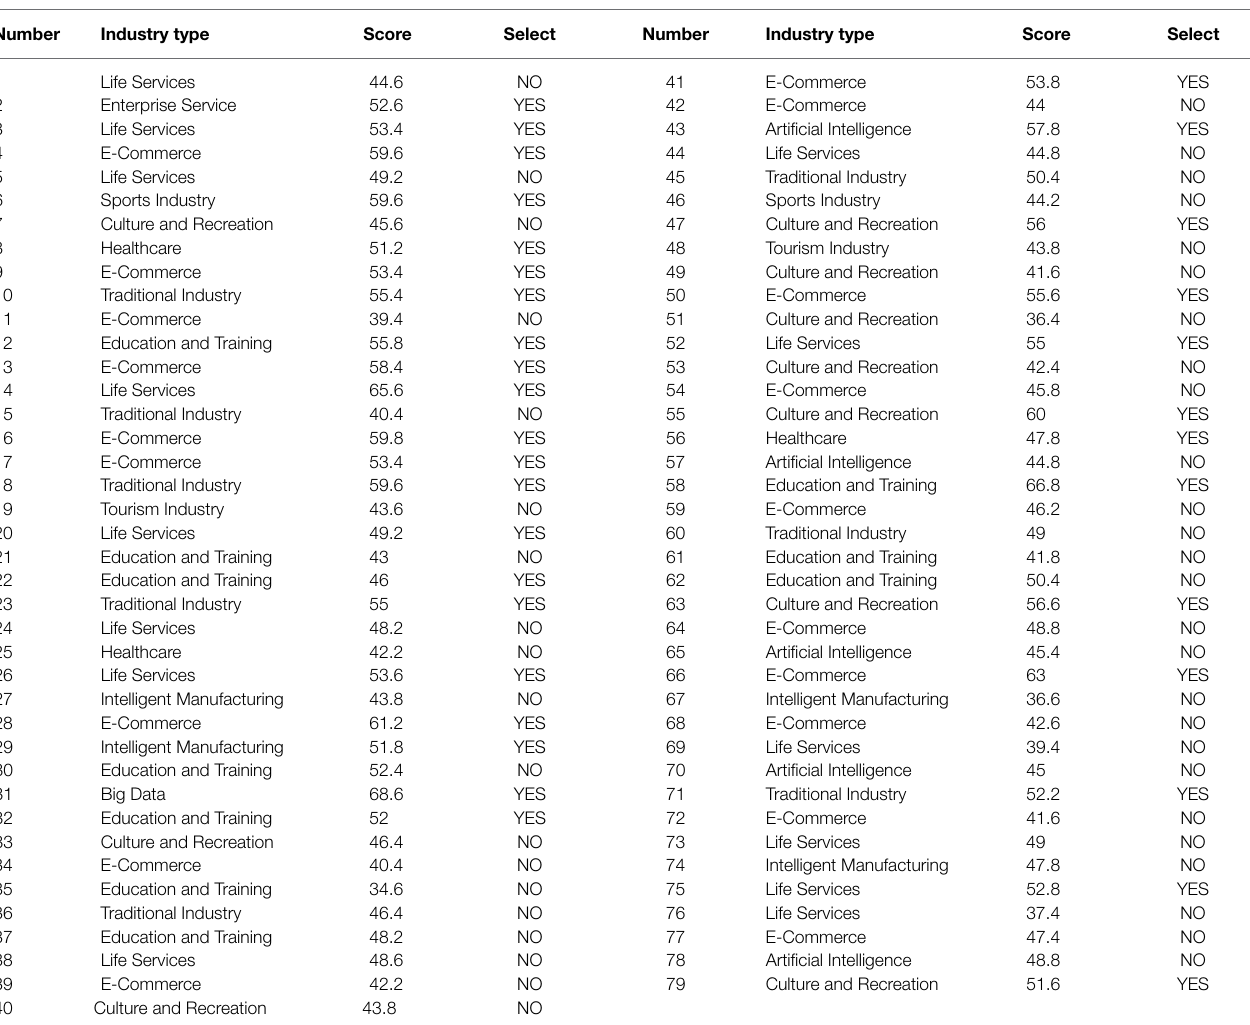
TABLE 1 | Deals total factor scores, selection stage disposition, and industry